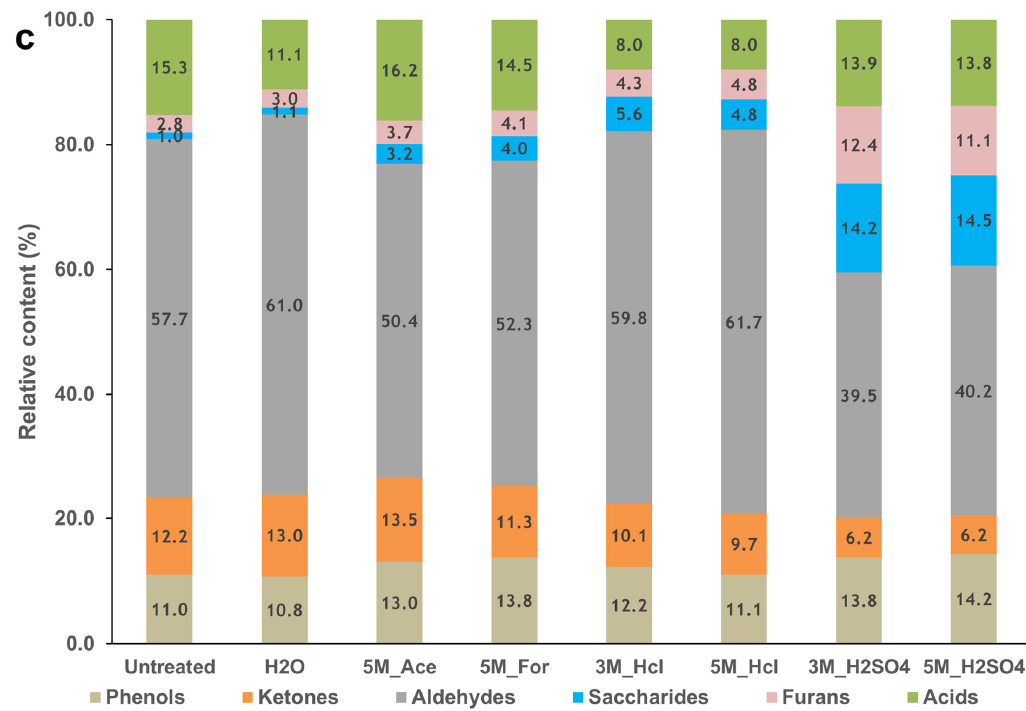
Figure 7. Effect of pretreatment on the pyrolytic products of PKS ( a ), MAH ( b ) and IRO ( c ). 3.6.1. Effect of Pretreatment on the Product Distribution of the Phenolic Compounds